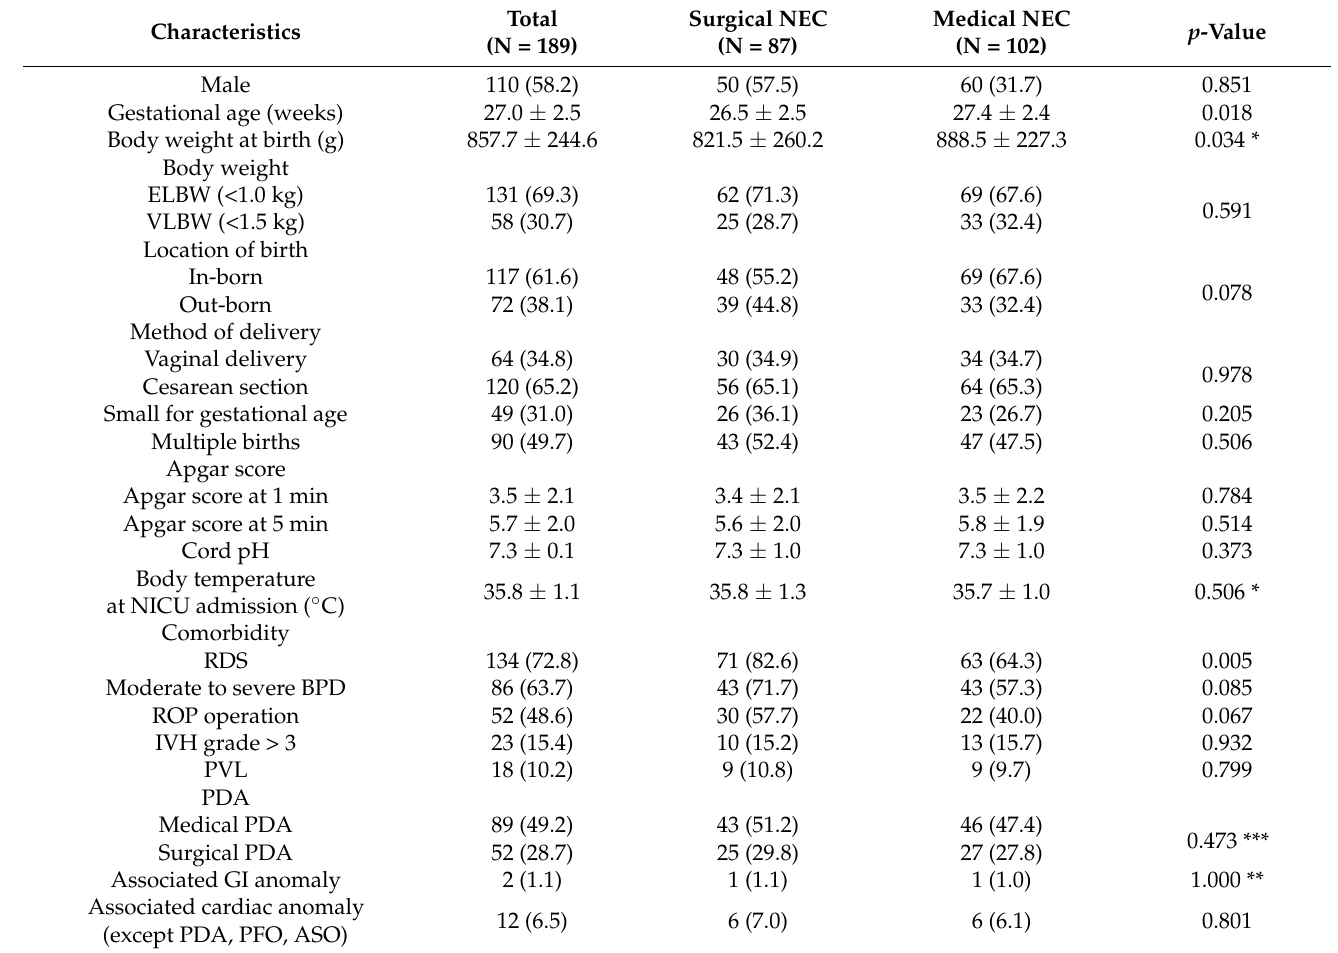
Table 1. Patient